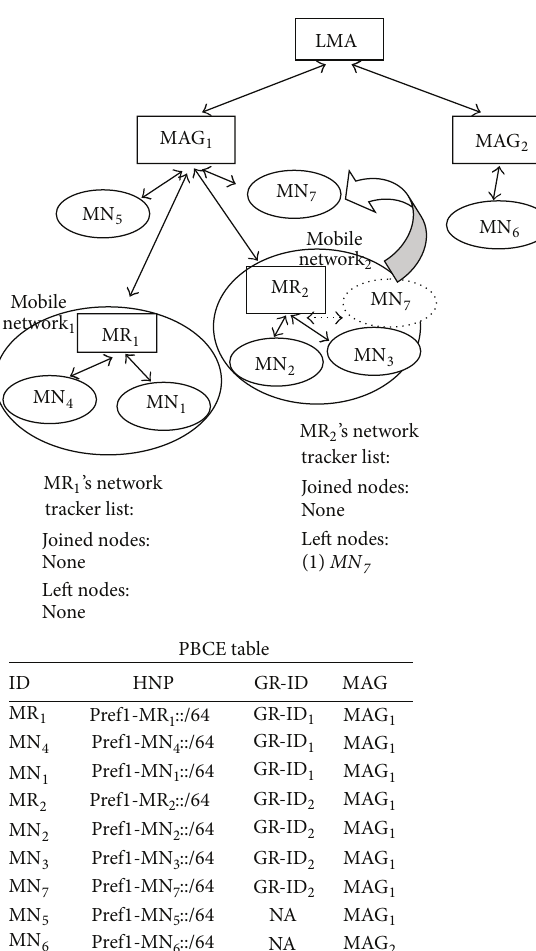
Figure 2: Intra-MAG movement: mobile node detaches from mobile network and attaches to